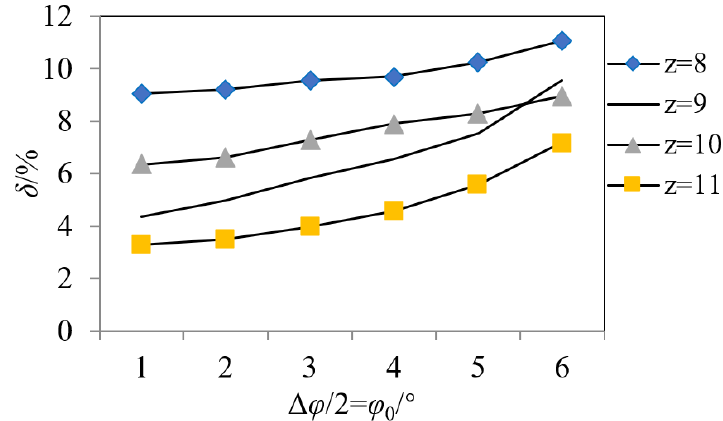
Figure 19. The flow pulsation rate curve of piston pump with 8~11 pistons under 6 flow distribution boundary conditions.